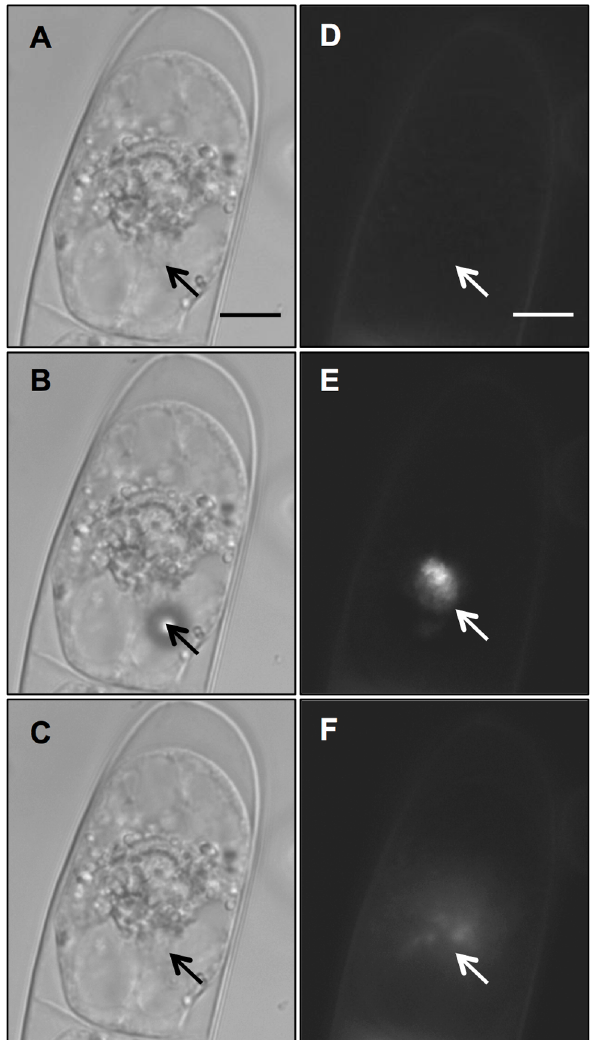
Figure 2. Optical injection of PI into a BY-2 cell. Shown in bright field (A–C) and fluorescence (D–F). A) Before shooting, B) transient bubble created on cell membrane during laser dose, C) no visible laser damage left post-irradiation. D) Pre-irradiation showing faint PI staining of the cell wall. E) Laser induced transient auto-fluorescence at the point of irradiation. F) Permanent increase in cytosolic fluorescence as PI enters the cell. Arrows indicate site of laser irradiation. Scale bar denotes 10 m